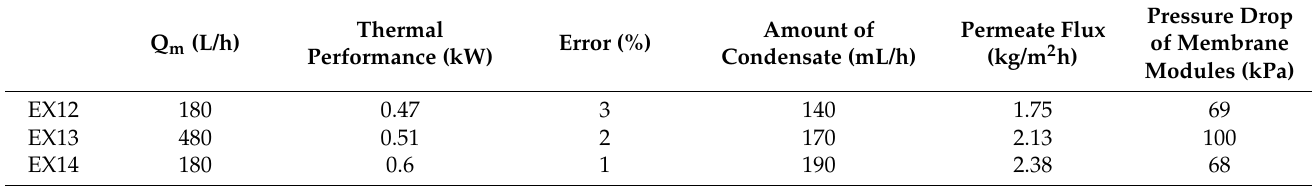
Table 7. Thermal performance, measurement error, condensate amount, permeate flux, and membrane module pressure drop for MM003.